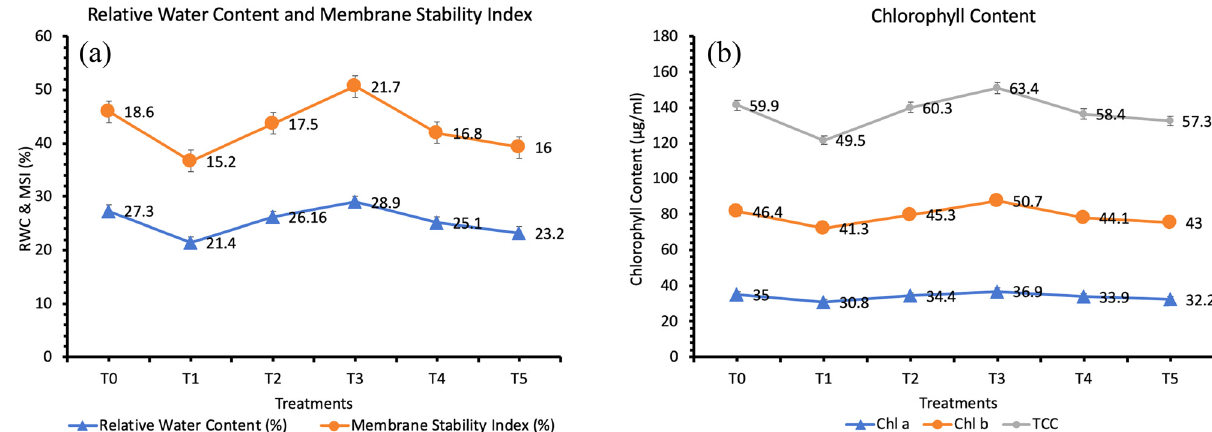
Figure 2: E ff ect of di ff erent treatments of AgNPs on the physiological parameters of rice plants under biotic stress: ( a ) relative water content and membrane stability index and ( b ) chlorophyll contents. Note: T0: control; T1: A. fl avus ( pathogen ) ; T2: 25 mg/L of AgNPs + A. fl avus ; T3: 50 mg/L of AgNPS + A. fl avus ; T4: 75 mg/L of AgNPs + A. fl avus ; T5: 100 mg/L of AgNPs + A. fl avus